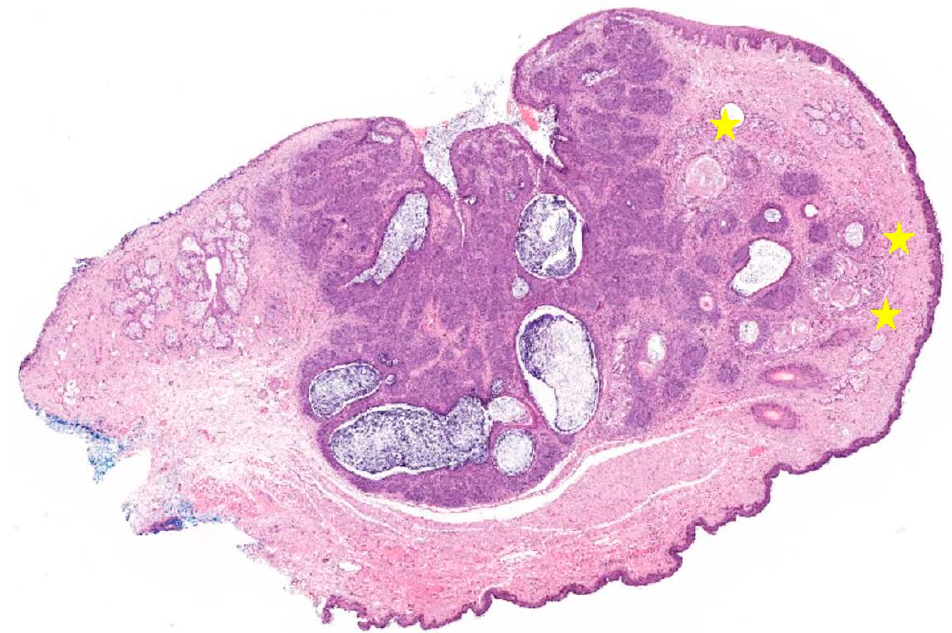
Figure 3. Basaloid Follicular Hamartoma (BFH) of the upper left eyelid (whole eyelid lesion). In the surgically excised, whole-eyelid lesion, one observed a basaloid malformative lesion centred in the cutaneous–conjunctival transition zone with features analogous to what had been previously described in the biopsy material (Figure 2). A mild foreign body type giant cell reaction was observed in the periphery of the tumour (yellow stars), most likely being associated with previous biopsy procedures. There was no evidence of malignant features and the diagnosis of BFH was confirmed (H&E, 4× magnification).